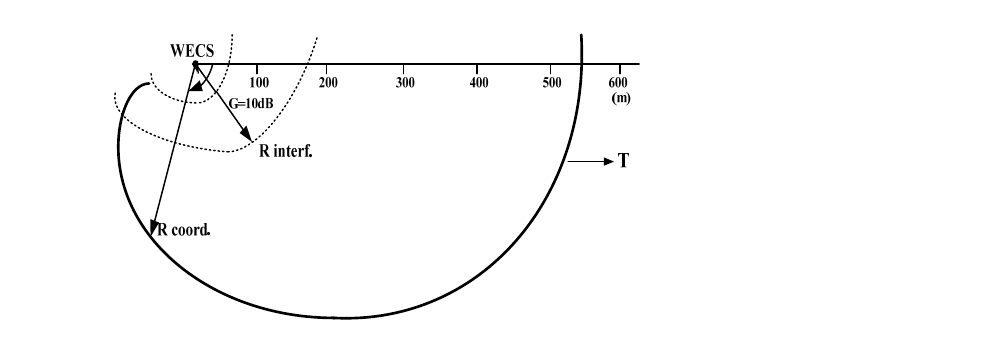
Figure 10. Adopted geometrical arrangement for the zone of co-ordination by Van Kats [54]. In terms of the co-ordination region, the blade was estimated using a rectangular ideal conducting screen, and the worst-case scattering condition of the wind turbine was considered as well. The RCS of the wind turbine is detailed in Equation (12).